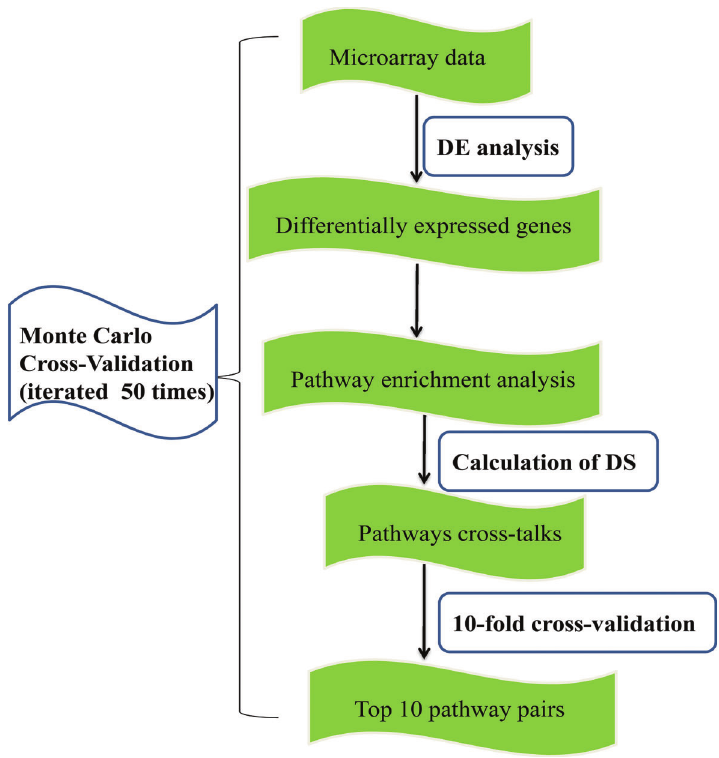
Figure 1. Flowchart displaying a brief overview of the main protocol. DE: differential expression; DS: discriminating score.